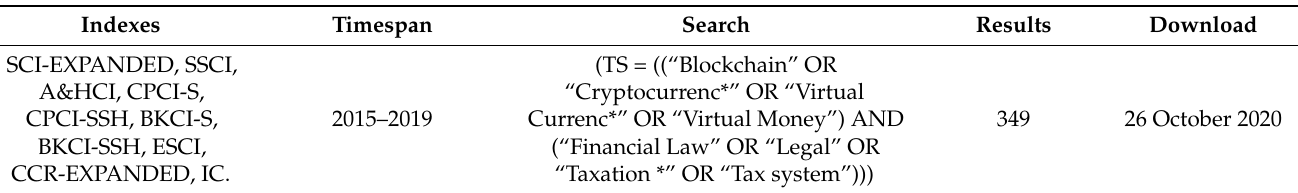
Table 1. Search query